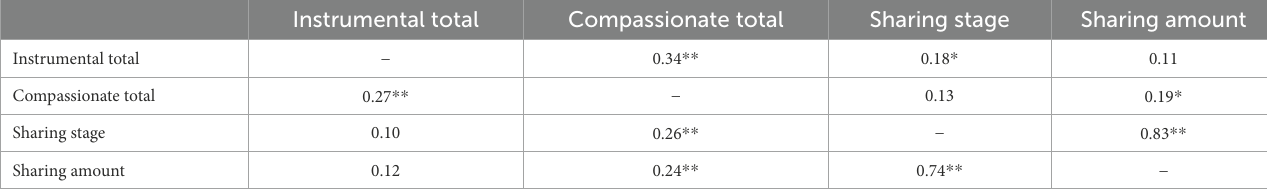
TABLE 3 Correlations between different subtypes of prosociality at each